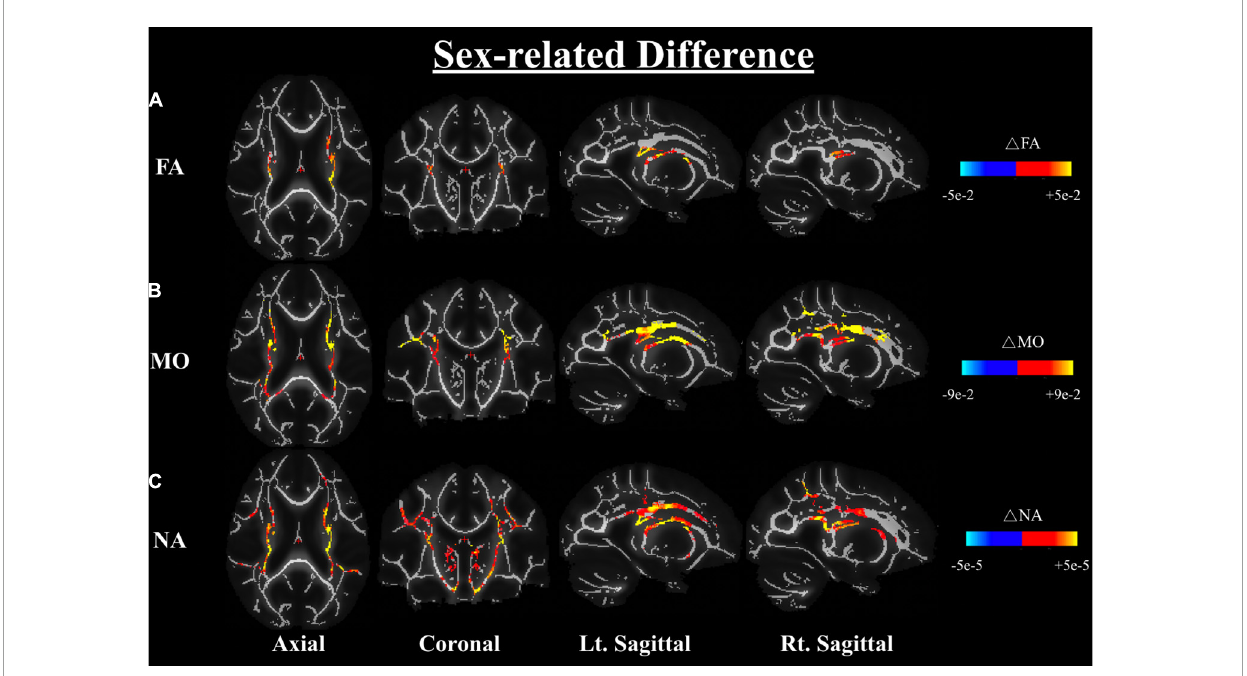
FIGURE4 Differences in FA (A) , MO (B) , and NA (C) between males and females based on a one-way ANOVA while controlling the APOE4 status (Analysis 3.1). Differences are shown in the axial, coronal, and left and right sagittal planes. The color bars indicate significant sex differences (at p < 0.05) in FA, MO, and NA whereby red-yellow means metrics have higher values in males than females, notably in the corona radiata and the internal capsule regions. FA, fractional anisotropy; MO, mode of anisotropy; NA, norm of anisotropy; ANOVA, Analysis of Variance.